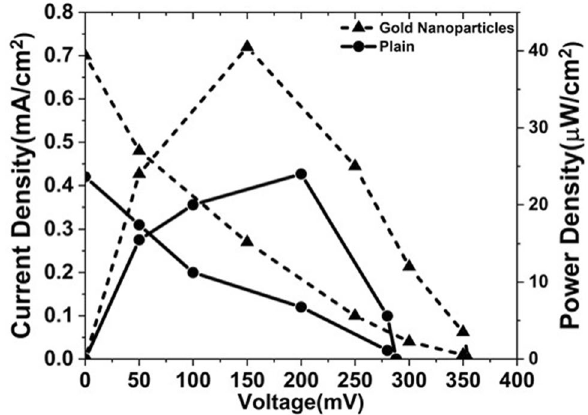
Figure 7. Polarization curves of the enzymatic biofuel cell with bioelectrodes coated with and without GNP.